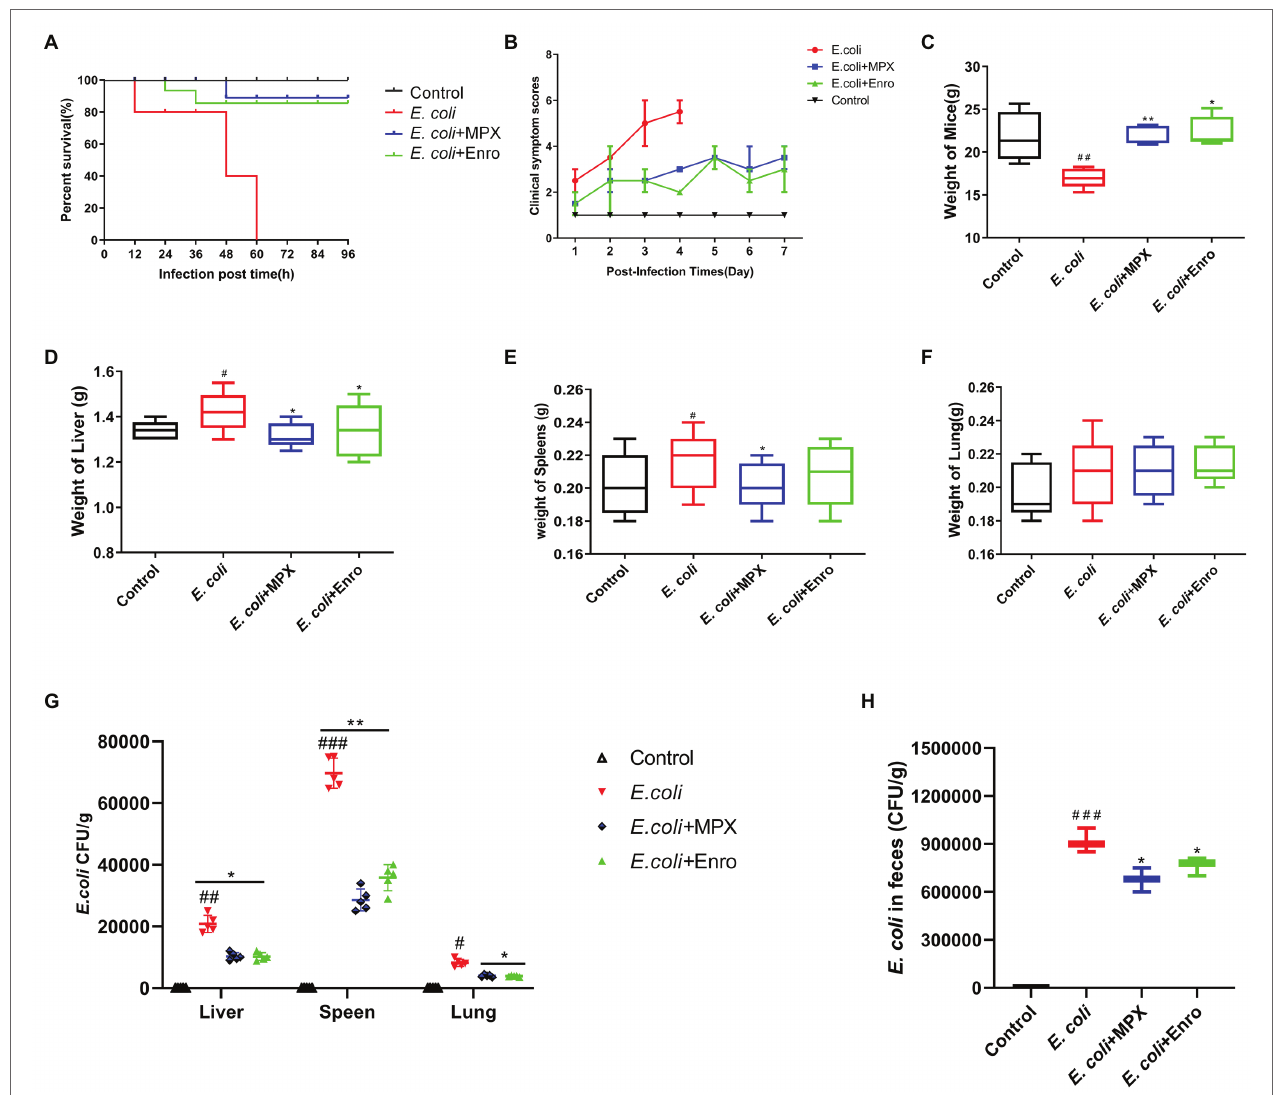
FIGURE 3 | MPX protects mice against infection with a lethal dose of E. coli . (A) The survival rate of mice infected with E. coli after MPX treatment. (B) The clinical symptom score of mice infected with E. coli after MPX treatment. (C) The weight of mice infected with E. coli after MPX treatment. (D-F) The weight of the liver, spleen and lung of mice infected with E. coli after MPX treatment. (G) The number of bacteria in the liver, spleen and lung of mice infected with E. coli after MPX treatment. (H) The number of bacteria in the feces of mice infected with E. coli after MPX treatment. Control group, mice injected with sterile saline; E. coli group, mice injected with E. coli ; MPX group, mice treated with intraperitoneal injection MPX and injected with E. coli . Error bars represent mean ± SEM, n = 5. Statistical significance was defined as follows: # P < 0.05; ## P < 0.01; ### P < 0.001 E. coli vs control; * P < 0.05; ** P < 0.01; *** P < 0.001 MPX and Enro treatment vs E. coli